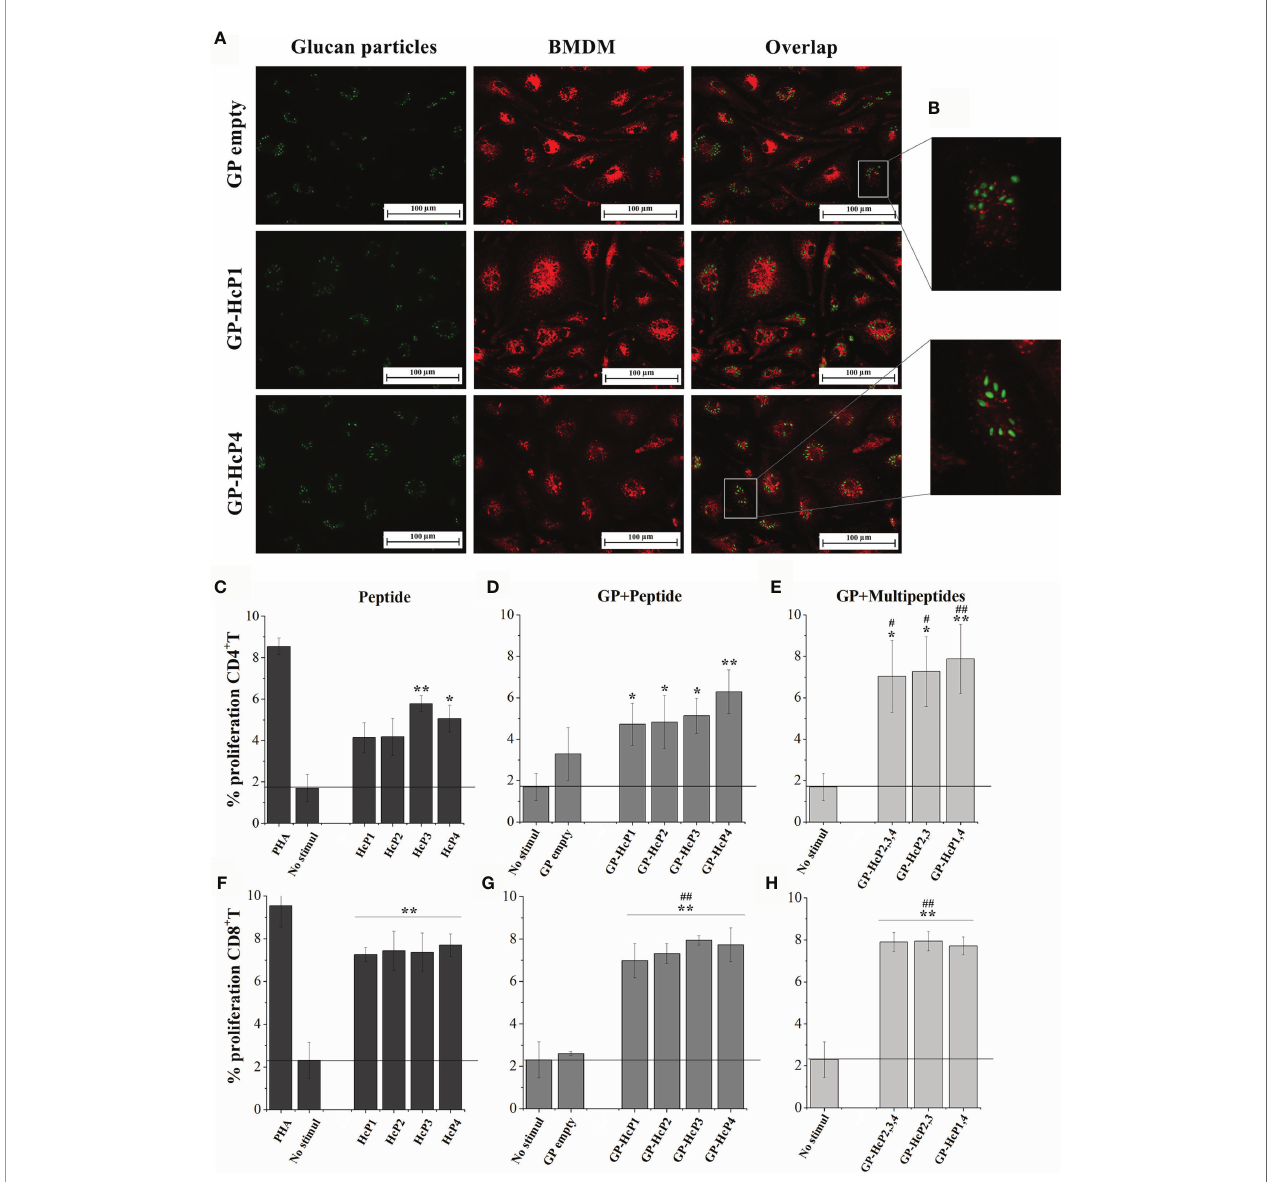
FIGURE 7 | Phagocytosis and proliferation of CD4 + and CD8 + T lymphocytes after exposure to the peptides and formulations of GPs. (A) Fluorescence microscopy of GPs empty and GP complexed with HcP1 and HcP4 (stained in green) ingested by BMDM (stained in red). Overlap: Both images, with GPs and BMDM, represent the same quadrant of the culture plate well according to the phagocytosis time of 3 hours. (B) Quadrant enlargement showing the shape of empty GPs and GP- HcP4. C-H. Splenocytes were collected from mice infected with H . capsulatum and marked with CFSE for re-stimulated with: (C, F) 10 µg/200µL HcP 1-4, (D, G) 5 µg/200µL GP-HcP 1-4 and (E, H) 5 µg/200µL GP-HcP 2,3,4; 2,3 or 1,4 for 96 hours. Control of cells stimulated with mitogen (PHA) and without stimuli were used for validation of the proliferative capacitive. Data shown are representative of four independent experiments. Differ from positive control by the Tukey ’ s test, *p < 0.05 or **p < 0.01. Differ from GP empty by the Tukey ’ s test, # p < 0.05 or ## p <